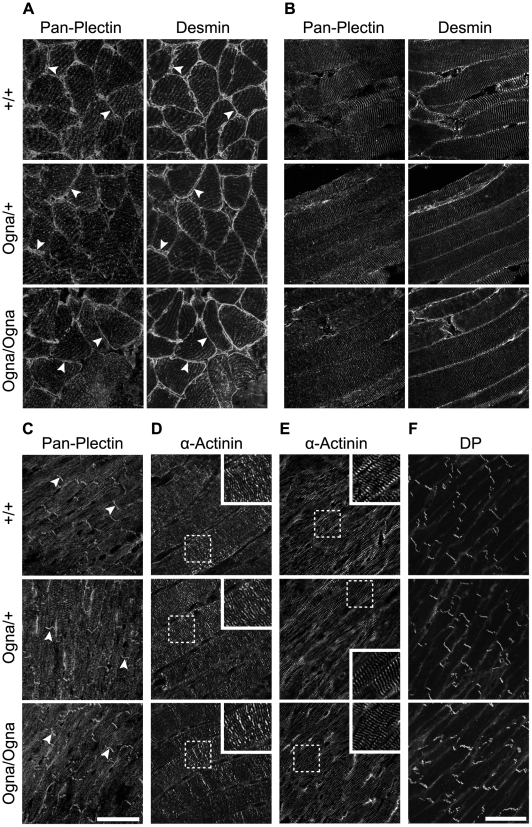
Normal plectin expression and contractile apparatus organization in muscle tissues of Ogna mice.(A,B) Cross sections (A) and longitudinal sections (B) of soleus muscle were double immunolabeled for plectin and desmin. Note, similar expression patterns of plectin and desmin at the sarcolemma (arrowheads) of Plec
+/+ and mutant muscle in (A). In longitundinal sections, plectin and desmin colocalized at Z-disks with no detectable difference in the staining patterns of Plec
+/+ and mutant tissues. (C) Cardiac muscle immunolabeled for plectin. Note similar staining pattern of plectin at Z-disks and intercalated disk structures (arrowheads) in all tissues. Bar in C, 50 µm (representative for A–C). (D–F) Sarcomeric units in soleus (D) and cardiac muscle (E,F) labeled with anti-α-actinin (D,E) and anti-desmoplakin (F) antibodies. Note normal alignment of sarcomers in both skeletal and heart muscle (D,E) as well as well preserved intercalated disk structures in cardiac muscle of mutant mice (F). Bar in F, 50 µm (representative for D–F).